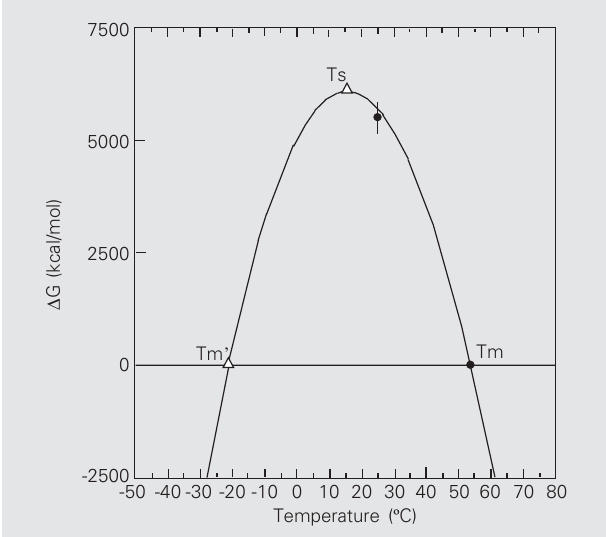
Figure 6. Stability curve of ß-trypsin: ∆ G D as a function of temperature ( º C), at pH 3.00, where Tm is the heat denaturation temperature, Tm’ is the theoretical cold denaturation temperature and Ts is the temperature of maximum stability of the protein under these experimental condi- tions. The value at 25 º C, 6.10 ± 1.03 kcal/mol, was obtained by solvent denaturation with urea as denaturant (21); the data were analyzed as a two-state